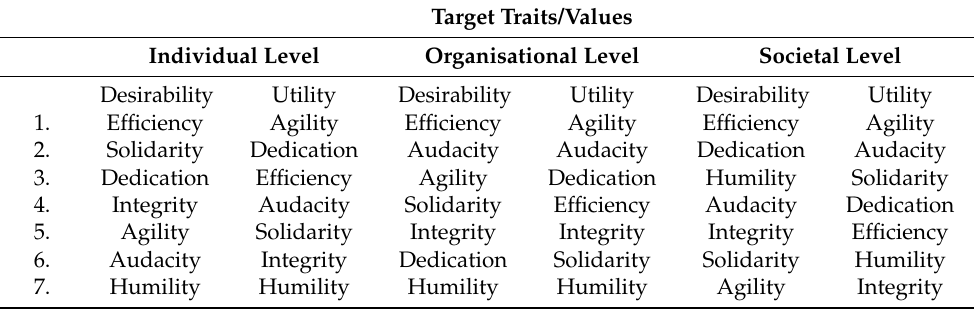
Table 1. Hierarchies of the useful and desirable values of responsible